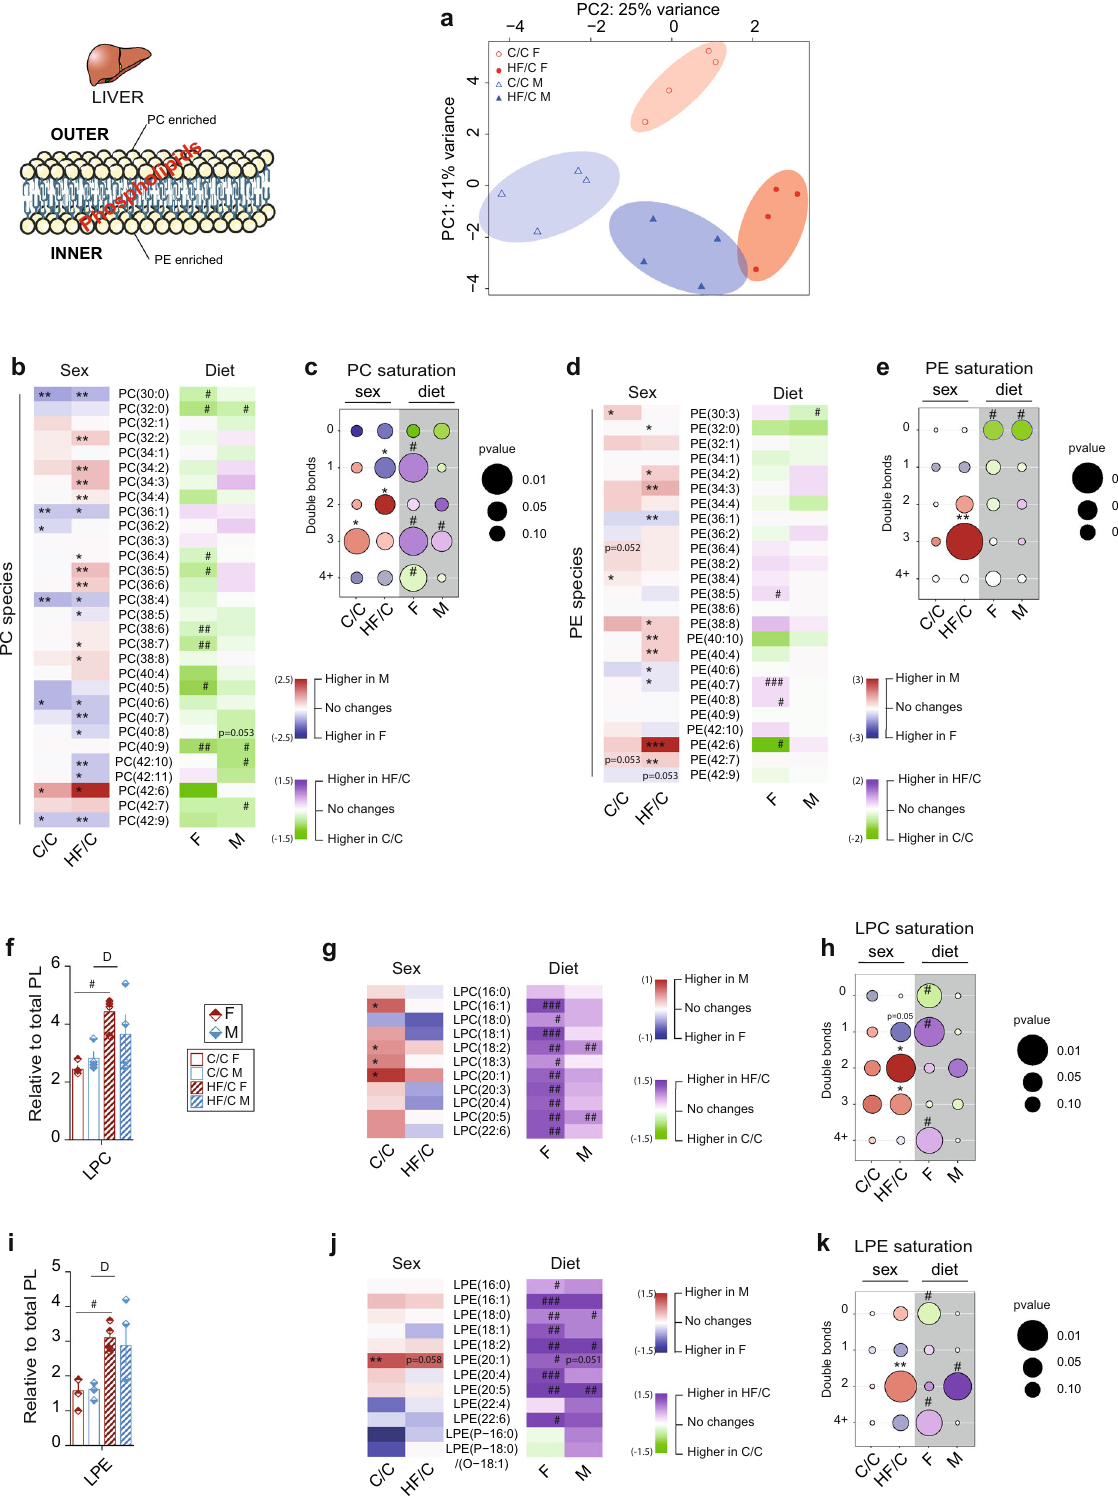
lipoproteins. We found 20% (1/5) in C/C and 40% (2/5) in HF/C P-PC species signi fi cantly different between M and F, whereas 92% (11/12) and 33% (4/12) of the P-PE species varied sig- ni fi cantly between M and F in C/C and HF/C groups, respectively (Fig. 5a, b). Overall, relative content and percentage of P-PC and P-PE were similar between sexes in C/C but were considerably higher in HF/C F than in HF/C M (Fig. 5c, d). This difference was